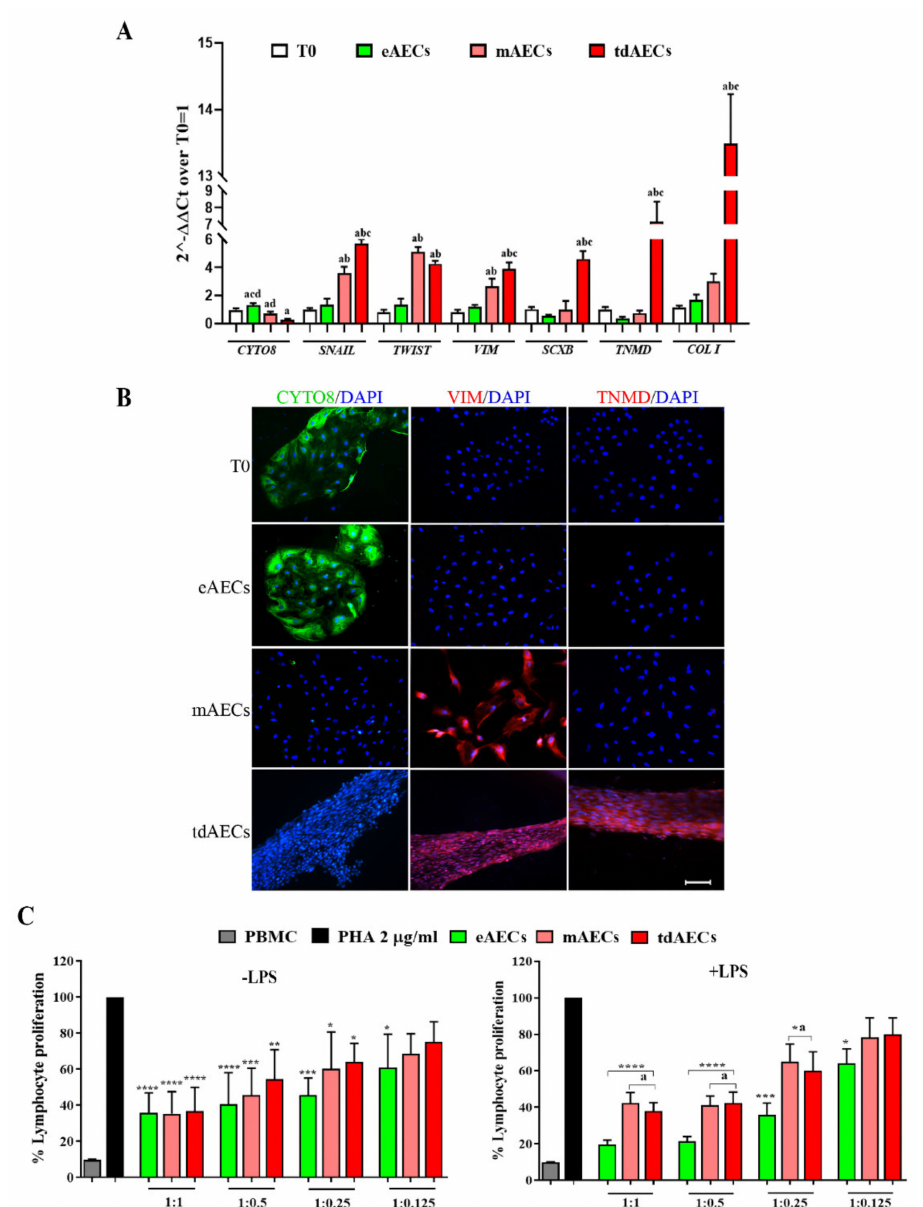
Figure 2. Characterization of oAECs under different culture conditions. ( A ) Gene expression profile assessed by real-time qPCR analysis of EMT ( CYTO8 , SNAIL , TWIST, and VIM ) and tendon-related genes ( SCXB , TNMD , COL 1 ) in mAECs, eAECs, and tdAECs. Values were considered significant for p < 0.05 and expressed with the superscript: a vs. T 0 , b vs. eAECs, c vs. mAECs, d vs. tdAECs. The quantitative data were expressed as mean ± S.D. ( B ) Representative ICC images of EMT and the tendon-related marker TNMD. ICC was assessed to detect the presence of CYTO8 (green fluorescence), VIM (red fluorescence), and TNMD (red fluorescence) protein in eAECs, mAECs, and tdAECs. Nuclei were counterstained with DAPI (blue fluorescence). Scale bar = 50 µ m. ( C ) Immunomodulatory effect of eAECs, mAECs, and tdAECs on PBMCs’ proliferation in absence or presence of LPS stimulus of in vitro culture by cell contact. The different subsets of oAECs were added to obtain different PBMC:oAEC ratios (1:1, 1:0.5, 1:0.25, 1:0.125). Data are represented as mean ± S.D. Values of independent experiments performed in triplicate. Statistical values were considered differently significant for * p < 0.05, ** p < 0.01, *** p < 0.001, and **** p < 0.0001 vs. PHA-stimulated PBMCs (in absence of the different subsets of oAECs) and a vs. eAECs. The quantitative data were expressed as mean ±